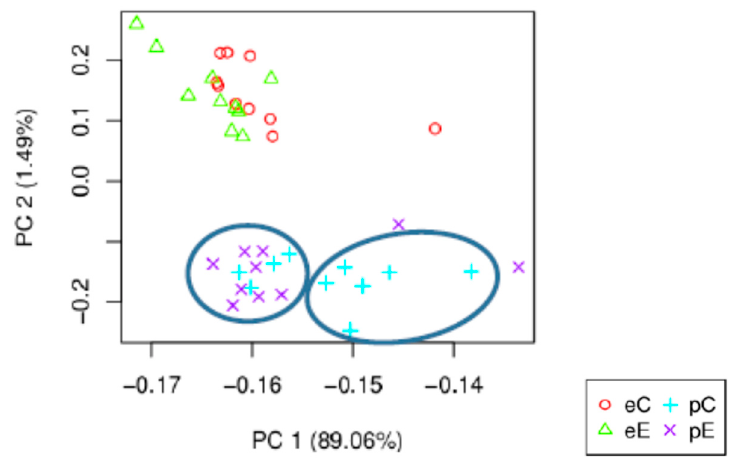
Figure 4. Principal component analysis (PCA) of foliar transcript profile expression of Q. pubescens trees; e and p denote sampling in summer and spring, respectively; C and E denote control and rain exclusion treatments, respectively. Circles denote a possible exclusion effect in spring.